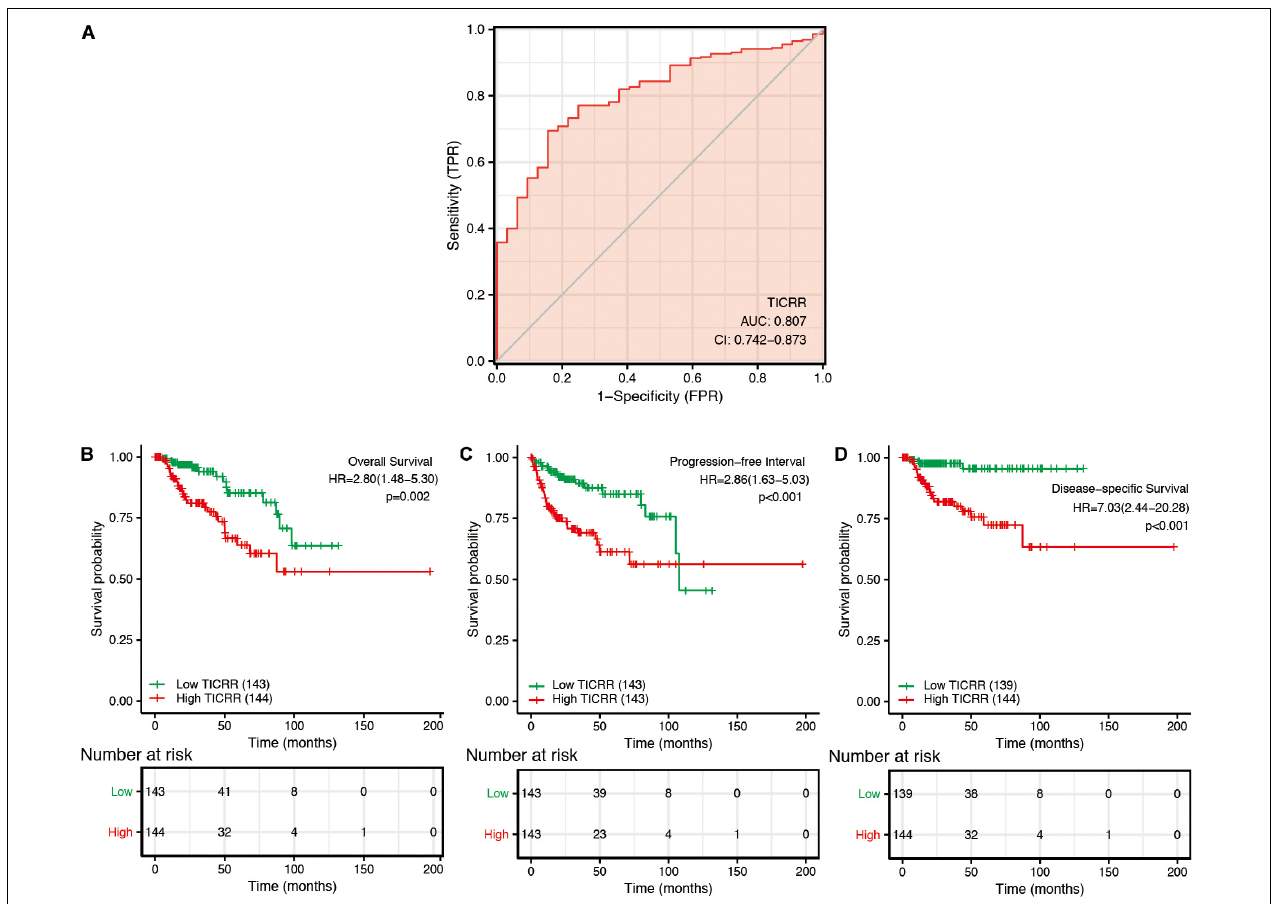
FIGURE 5 | Predictive value of TICRR expression for diagnosis and clinical outcomes in papillary renal cell carcinoma (PRCC) patients. (A) Receiver operating characteristic (ROC) curve analysis evaluating the performance of TICRR for PRCC diagnosis. Shown are the Kaplan–Meier analyses comparing overall survival (B) , progression-free interval (C) , and disease-specific survival (D) between high- and low- TICRR expression groups.